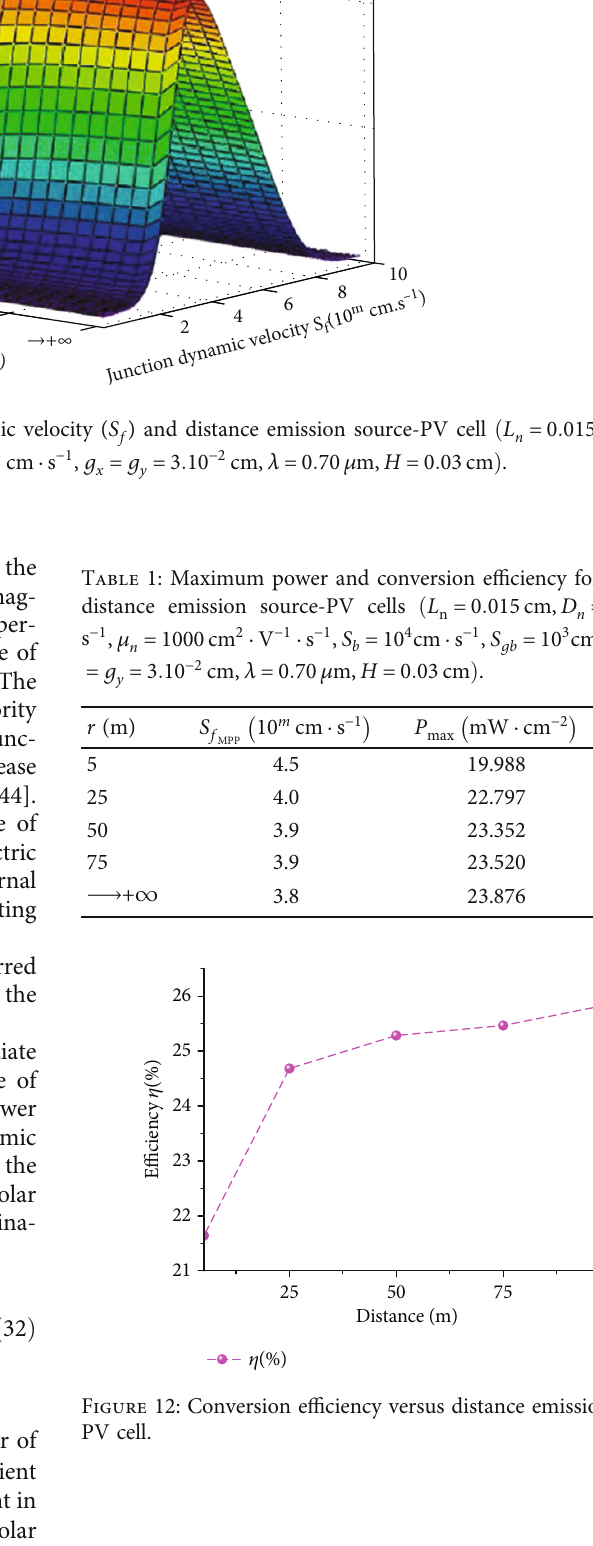
Figure 12: Conversion e ffi ciency versus distance emission source- PV